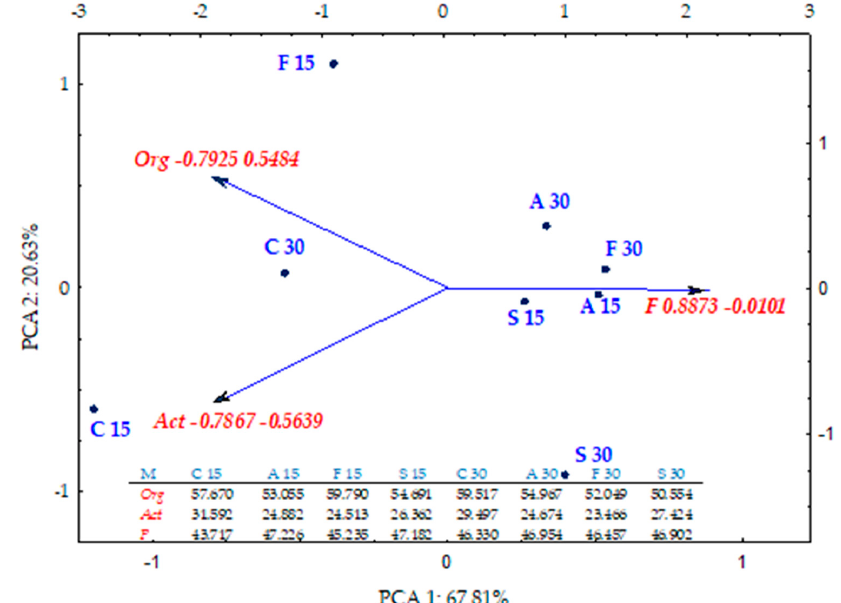
Figure 4. Colony development index (CD) for Org—organotrophic bacteria, Act—Actinomycetes and F—fungi in soil contaminated BPA, BPF and BPS on the 15th and 30th day of research—PCA method; M—groups of microorganisms; C—control; A—soil contaminated with BPA; F—soil contaminated with